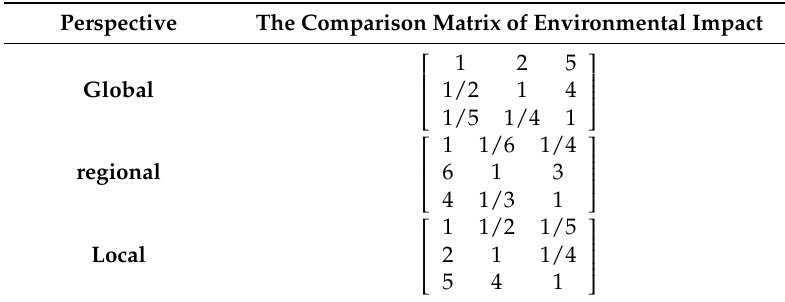
Table 18. The comparison matrix of environmental impact of di ff erent perspective.